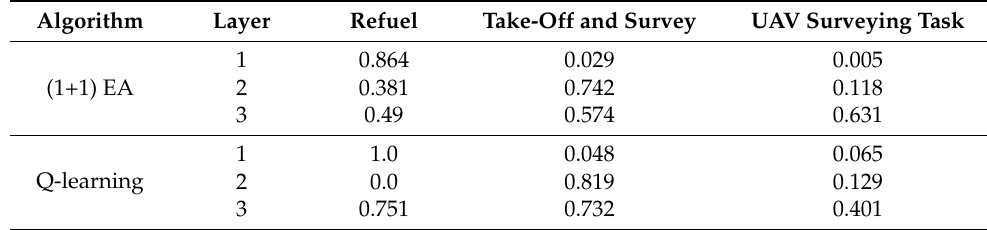
Table 3. Average subtask performance after each layer for complementary layered learning.